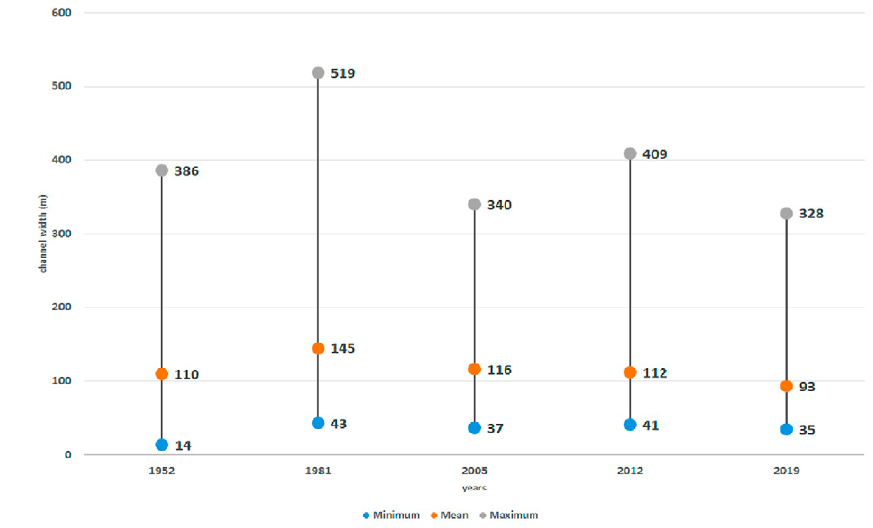
Figure 9. The width channel variation between 1952 and 2019 Table 2. The number and surface of mid-channel bars in the last century